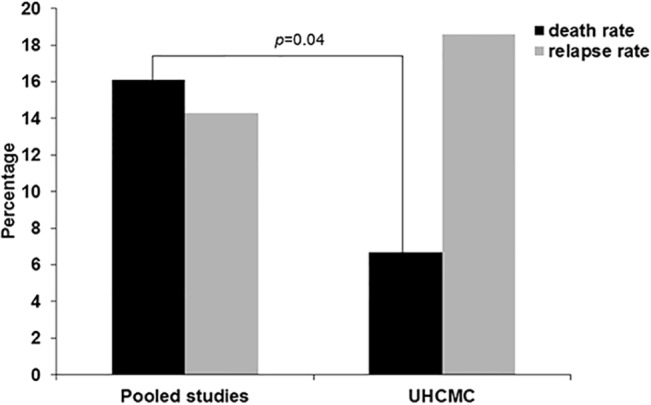
Thirty-day mortality and relapse in TTP-HUS.Thirty-day mortality attributed to TTP-HUS was 2% (1/48); however, overall mortality for patient cohort was 6.7% (4/59) (3 patients died of causes unrelated to TTP-HUS diagnosis (engraftment failure and graft vs. host disease, multi-organ failure due to sepsis and bacteremia, and heart failure due to worsening ejection fraction). Pooled 30-day mortality rate is 16.1% (92–571), p = 0.04. Relapse rate between our entire patient cohort (18.6%) and that of pooled data (14.3%).